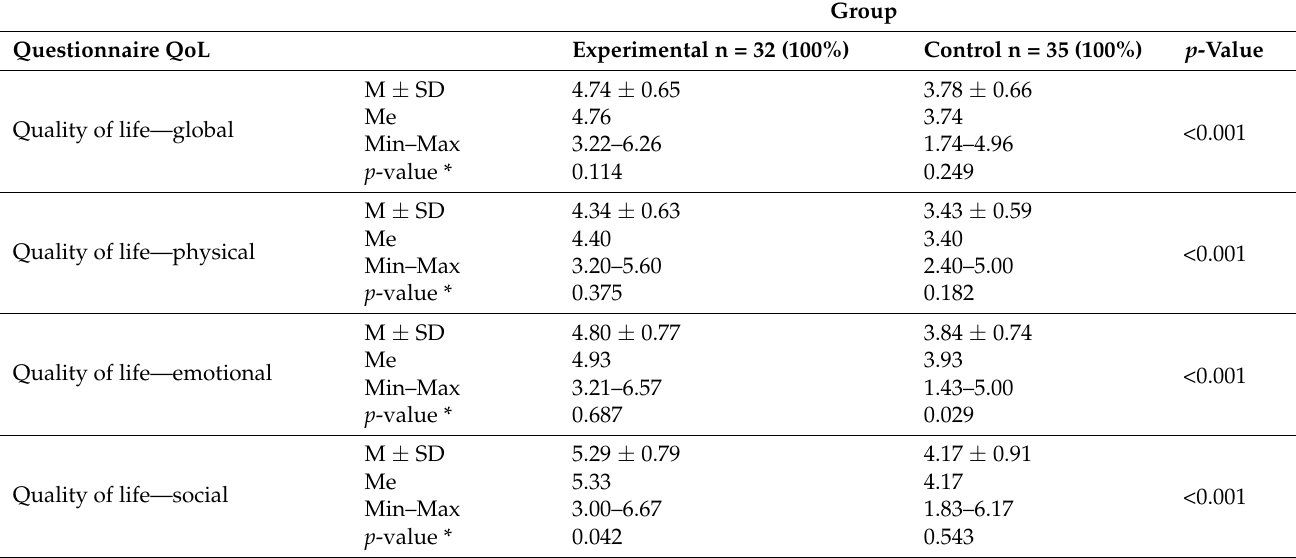
Table 6. Quality of life assessment scale